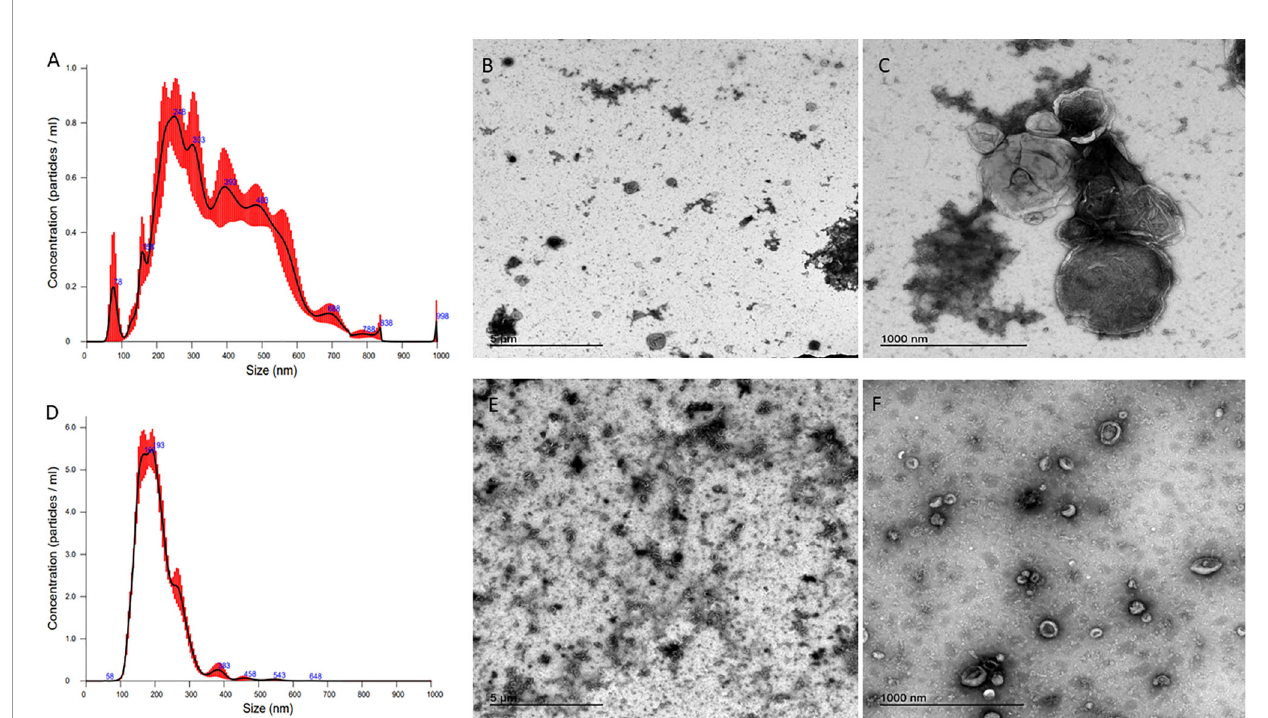
FIGURE 2 | (A, D) are nanoparticle tracking analysis (NTA) graphs of medium/large and small STBEVs, respectively, while (B) (wide angle) and (C) (close-up) are transmission electron microscopy images of medium/large STBEVs. (E) (wide angle) and (F) (close up) are transmission electron microscopy images of small